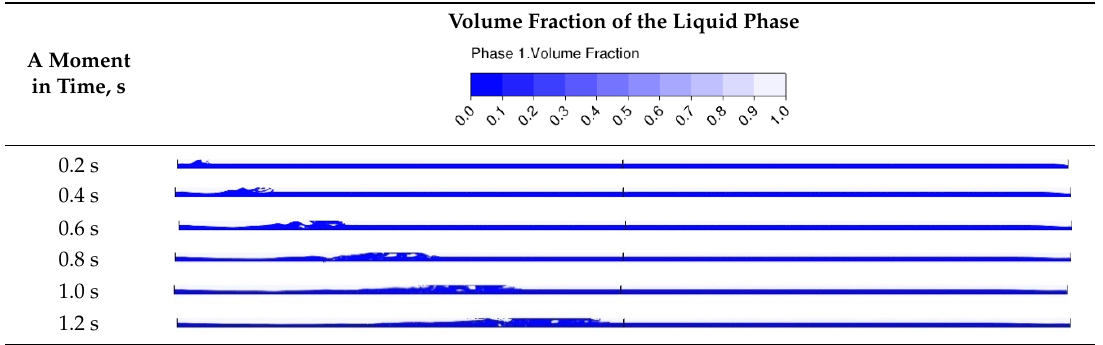
Table 8. The volume fraction of the liquid phase in consecutive moments of time in a system with mesh partitions.